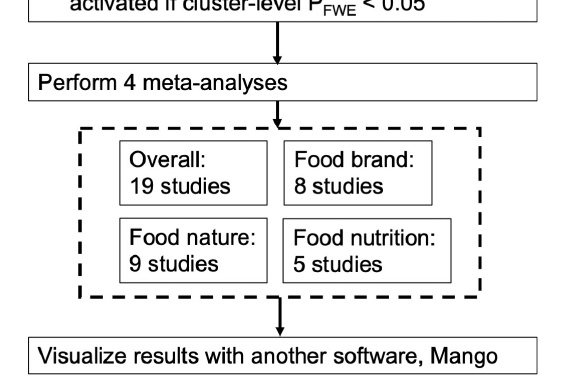
FIGURE2 Flow chart that illustrates the process of activation likelihood estimation (ALE)